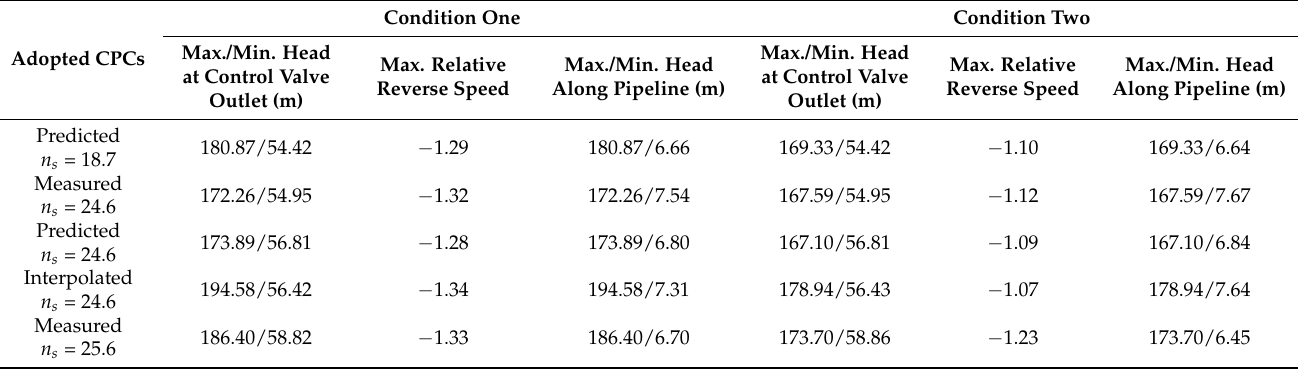
Table 3. Extreme values under valve rejection and valve two-stage closing